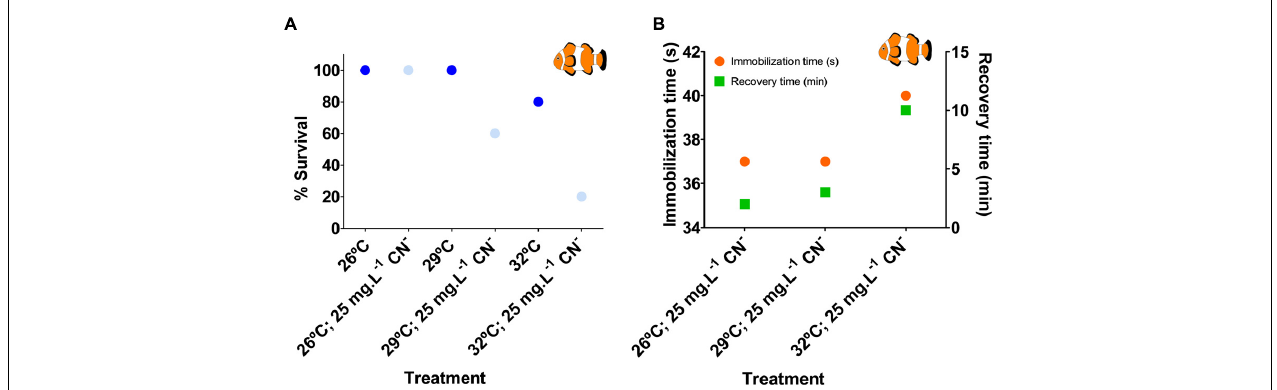
FIGURE 4 | Effects of cyanide pulse exposure (25 mg L - 1 for 60 s) and elevated temperature (+3 and +6 ◦ C above control) on tropical reef clownfish ( Amphiprion ocellaris ) (A) survival (%) 96-h post-exposure; and (B) immobilization time (s) and recovery time (min). Fish solely exposed to elevated temperature were not tested for these parameters. Ten fish were used per treatment. Immobilization time is the time at which the last fish of a treatment stopped swimming and remained motionless while recovery time is the time at which the last fish of a treatment returned to normal swimming activity.